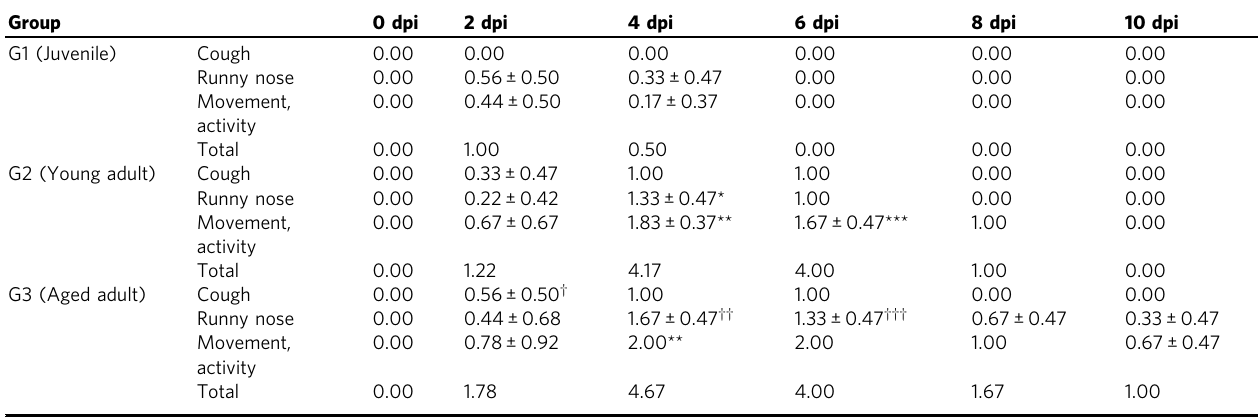
Table 1 Clinical scores of ferrets infected with SARS-CoV-2. Group